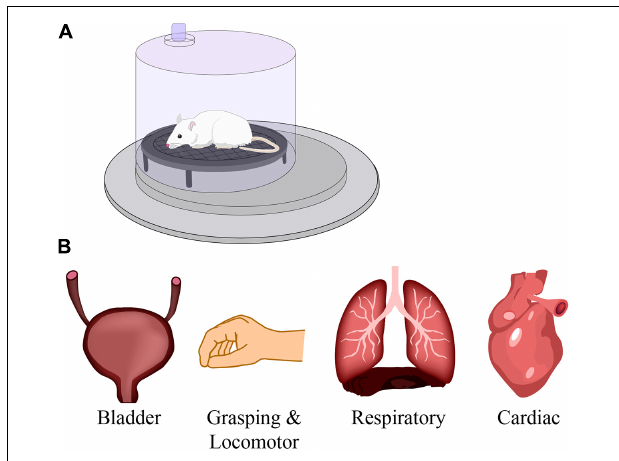
FIGURE 5 | The effect of respiratory training on neural networks. The studies described in this review use respiratory training, such as intermittent hypoxia and hypercapnia in a pre-clinical model (A) , to improve respiratory function after spinal cord injury. However, numerous studies have reported beneficial effects on other motor networks such as bladder, grasping and locomotion, and cardiac systems (B) . Modified from Zholudeva and Lane